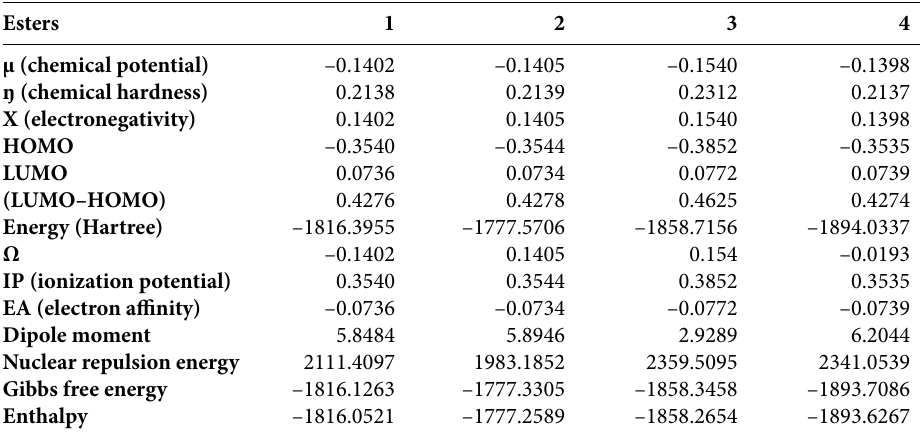
Table 6. Global chemical reactivity indices of synthesized esters